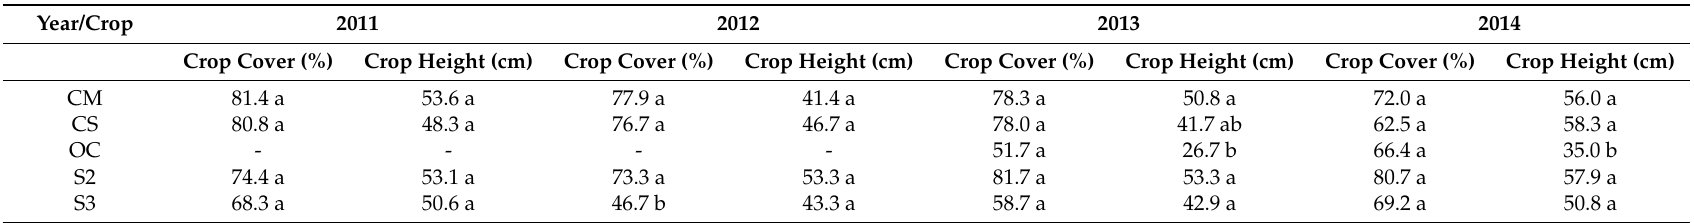
Table 7. Mean crop cover (%) and crop height (cm) in the different crops. CM: cereal monocrop, CS: cereal after sainfoin, OC: organic cereal, S2: sainfoin second year, S3: sainfoin third